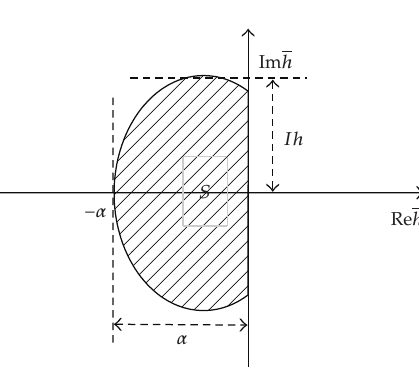
Figure 1: Region of absolute